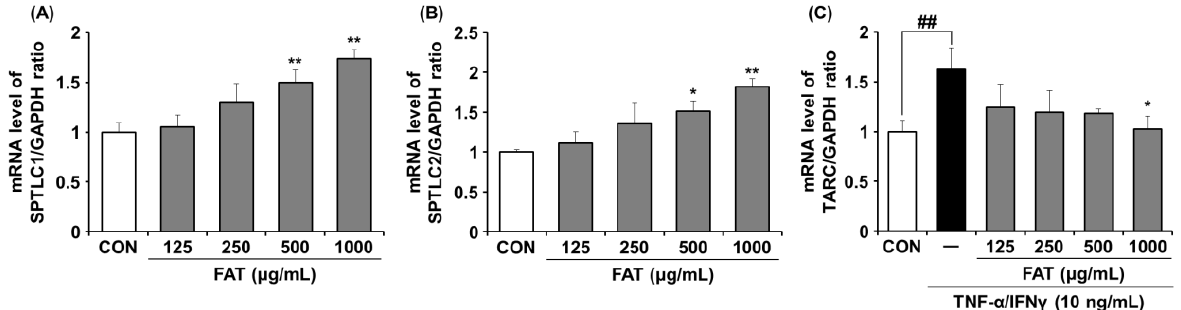
Figure 3. Effects of FAT on the mRNA expression of SPT and TARC in HaCaT cells. ( A ) SPTLC1, ( B ) SPTLC2, and ( C ) TARC were determined by RT-PCR. Data represent the mean ± SD of three independent experiments. Statistical significance was assessed by one-way ANOVA followed by Tukey’s test. * p < 0.05, ** p < 0.01, and ## p < 0.01 compared with the untreated cells and control, respectively. compared with the untreated cells. FAT; Fermented Angelicae tenussimae with Aspergillus oryzae , SPTLC1; Serine Palmitoyltransferase Long Chain Base Subunit 1, SPTLC2; Serine Palmitoyltransferase Long Chain Base Subunit 2, TARC; Thymus and activation-regulated chemokine, TNF- α ; Tumor necrosis factor α, IFN- γ; Interferon γ.